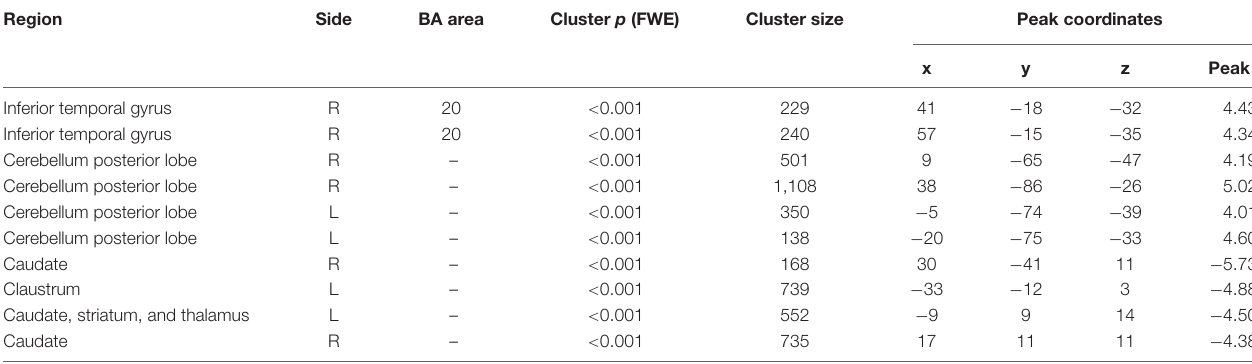
TABLE 1 | Results of the voxel-based morphometry analysis. Region Side BA area Cluster p (FWE) Cluster size Peak coordinates